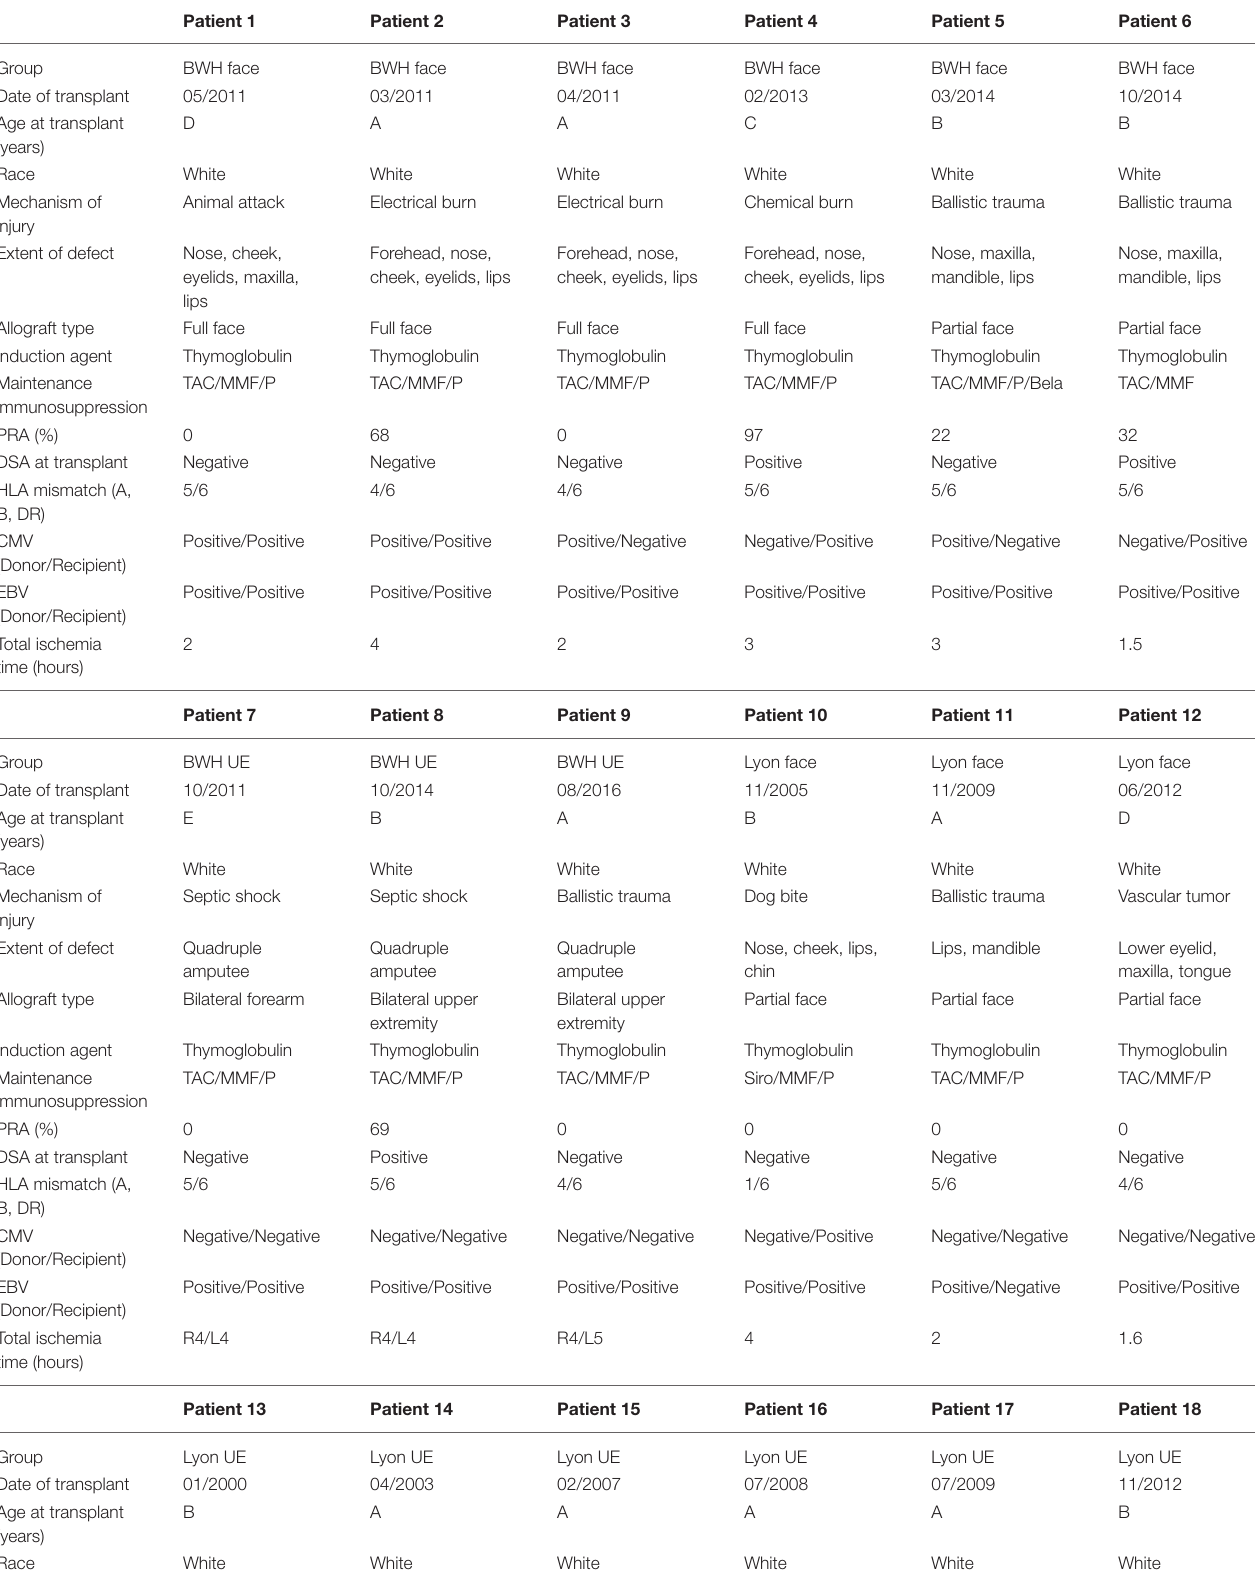
TABLE 1 | Face and upper extremity transplant recipients’